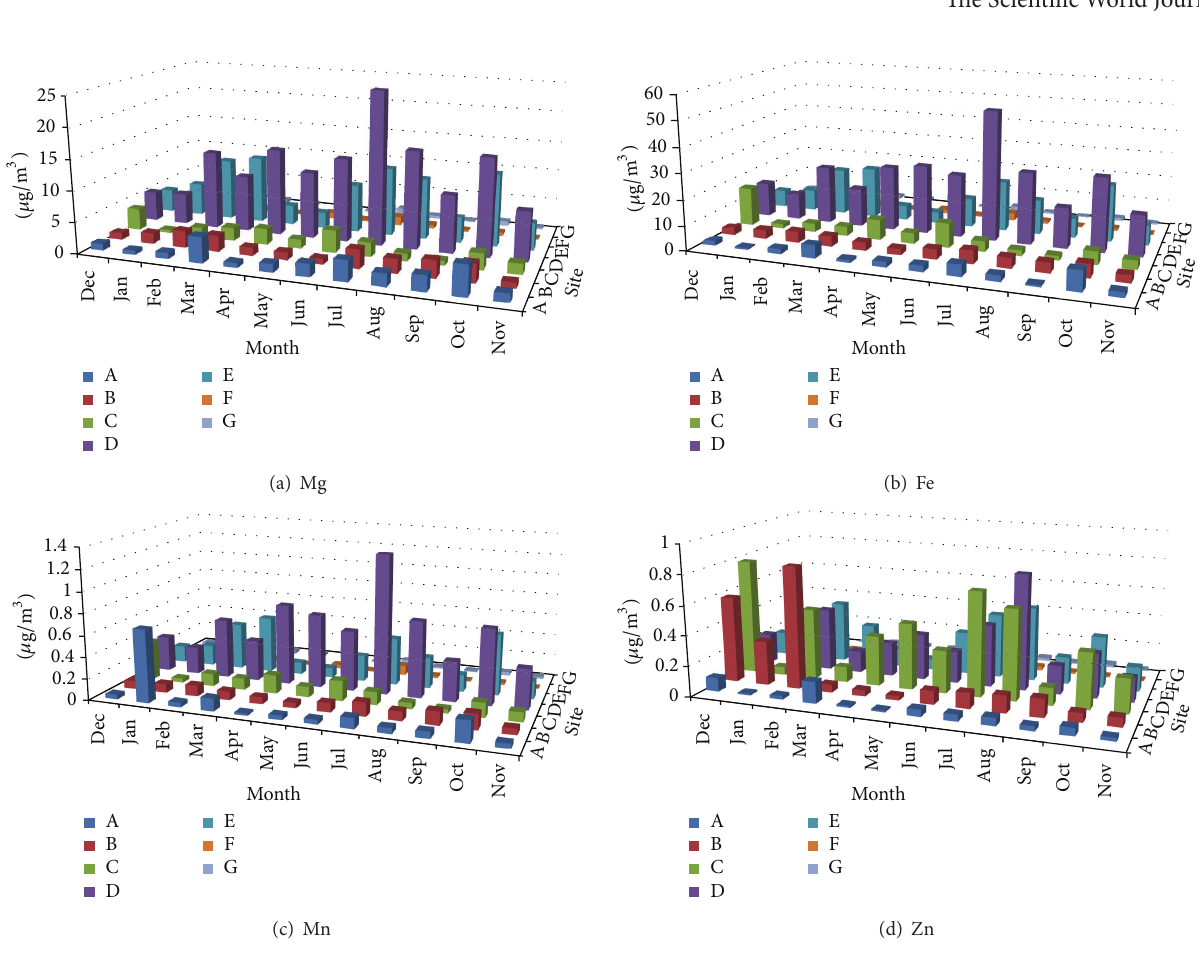
Figure 3: Spatial and temporal distribution of Mg, Fe, Mn, and